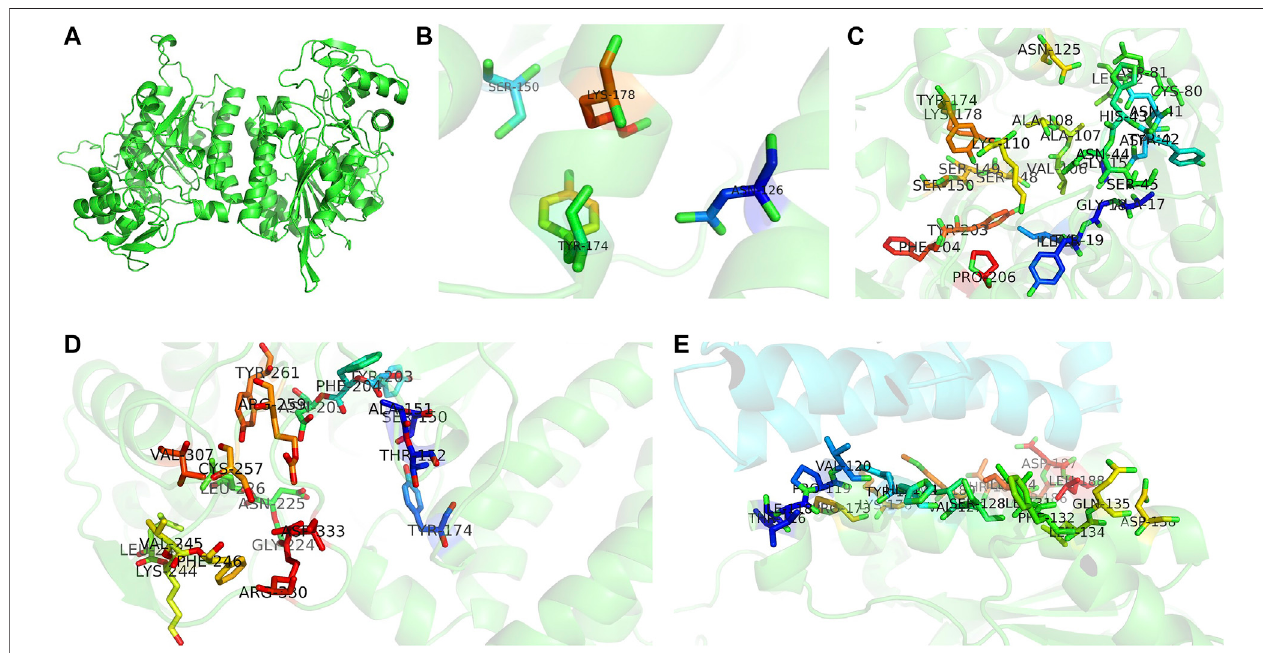
FIGURE 2 | Three-dimensional structures of UDP-glucose-4-epimerases in H. erinaceus . (A) Homodimer was developed by homology modeling. (B) Active sites (N126, S150, Y174, K178) were illustrated in colored sticks. (C) NAD binding sites of H. erinaceus UGE were shown in colored sticks (G16, A18, G19, Y20, I21, C80, D81, L82, V106, A107, A108, K110, N125, S148, S149, S150, Y174, K178, Y203, F204, and P206). (D) Homology modeling of substrate binding sites (S150, A151,T152, Y174, Y203, F204, N205, G222, N225, L226, L243, K244, V245, F246, C257, R259, Y260, and V307). (E) Monomer interactions caused by peptide binding sites in homodimer interface (T116, I118, P119, V120, Y123, H124, V127, S128, I131, F132, L134, Q135, D138, P173, K176, M180, T183. I184, D186. D187, and L188). All models were generated by PyMOL.